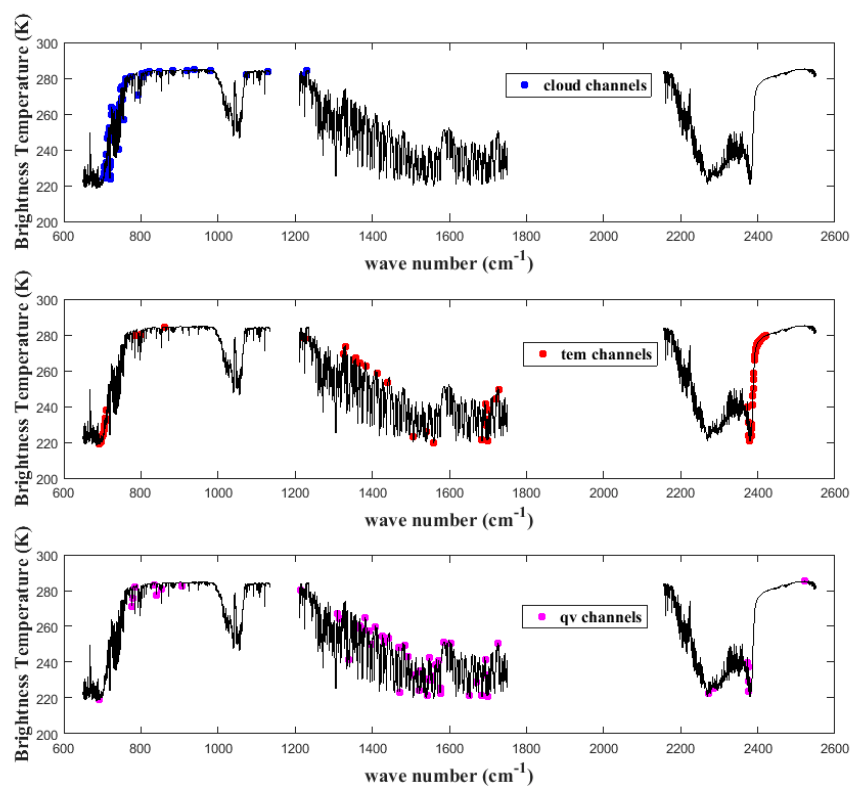
Figure 4. Selected channels used during the process of retrieval. The blue dots represent cloud channels. The red dots represent temperature channels and the magenta dots represents vapor channels.